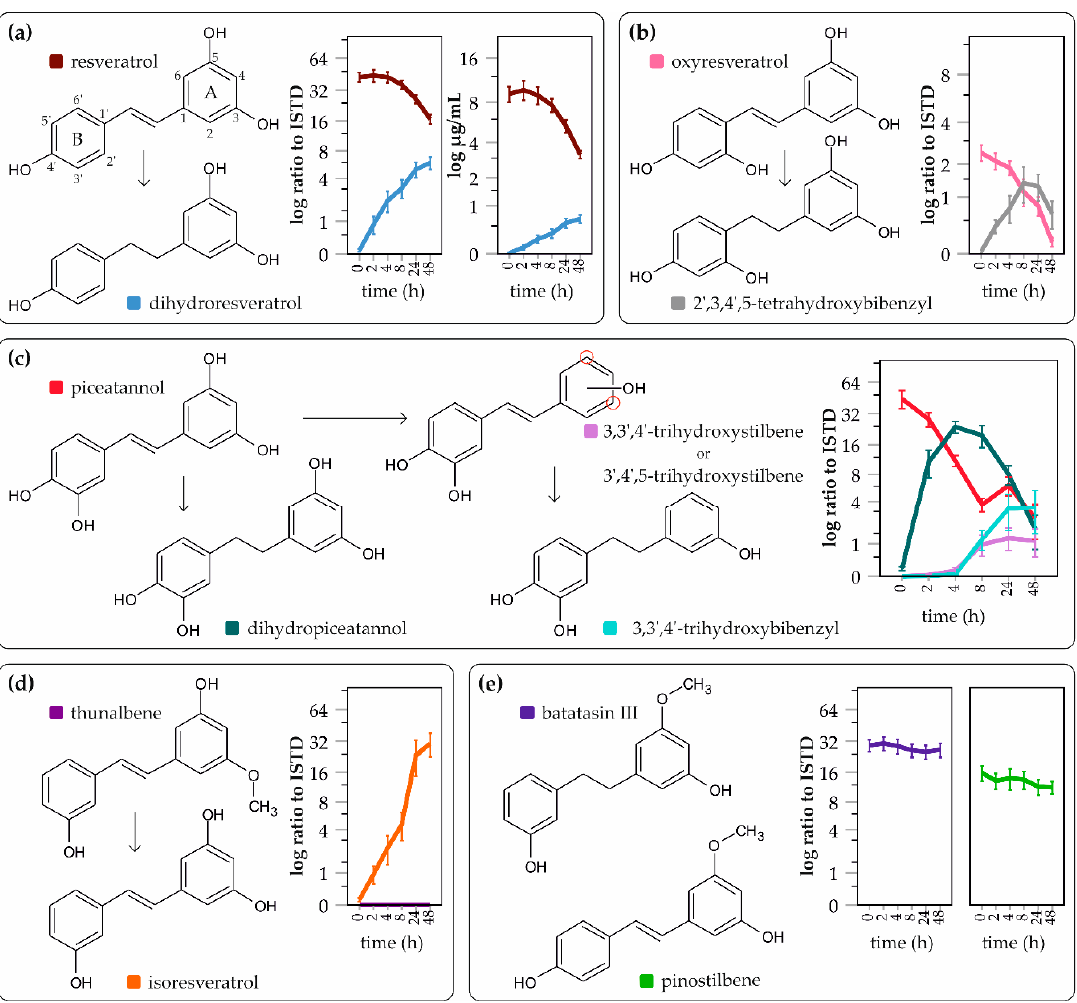
Figure 1. The effect of bacterial metabolism on ( a ) resveratrol ( N = 5); ( b ) oxyresveratrol ( N = 3); ( c ) piceatannol ( N = 5); ( d ) thunalbene ( N = 5); ( e ) batatasin III ( N = 4); and pinostilbene ( N = 5); values obtained from LC/MS are expressed as ratios of produced metabolite to internal standard (ISTD) as means ± 1 SE ( p < 0.05); N represents the number of donors analyzed.